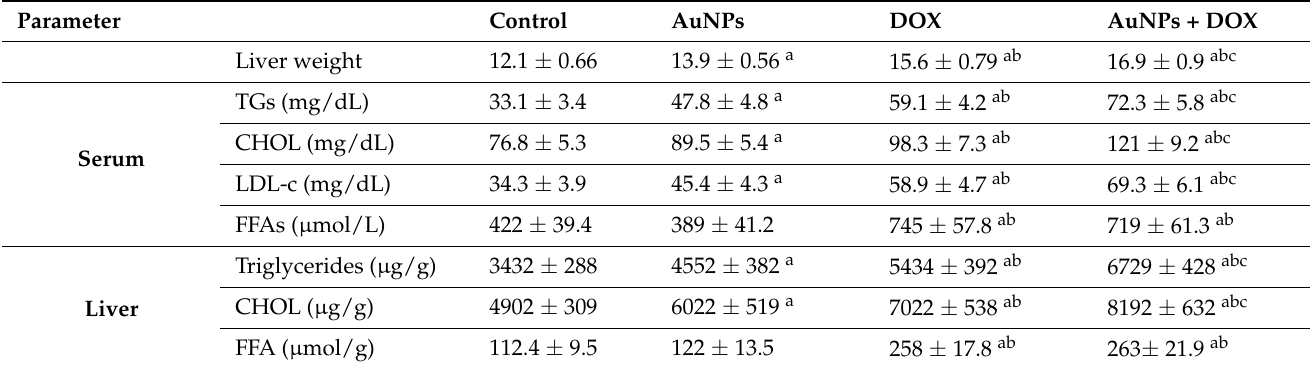
Table 2. Effects of the individual or combined treatments with gold nanoparticles (AuNPs) and/or doxorubicin (DOX) on liver weights and serum/hepatic lipids in all